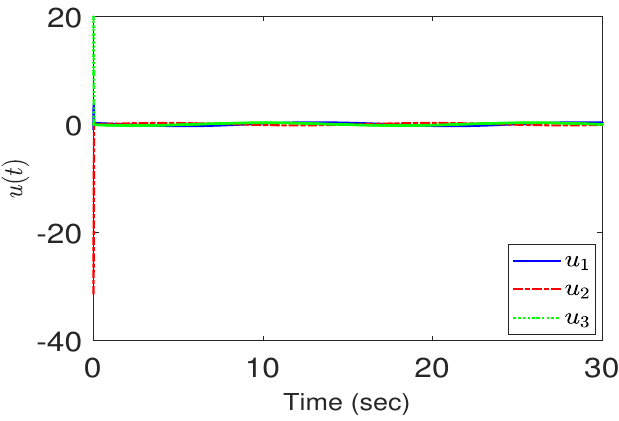
Figure 7. Tracking errors vs. time under a PPC in Case 2